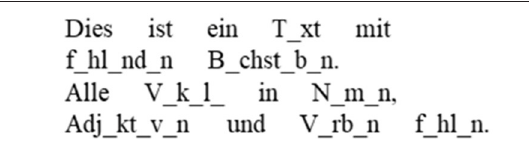
FIGURE 1 | Example of a deleted letter